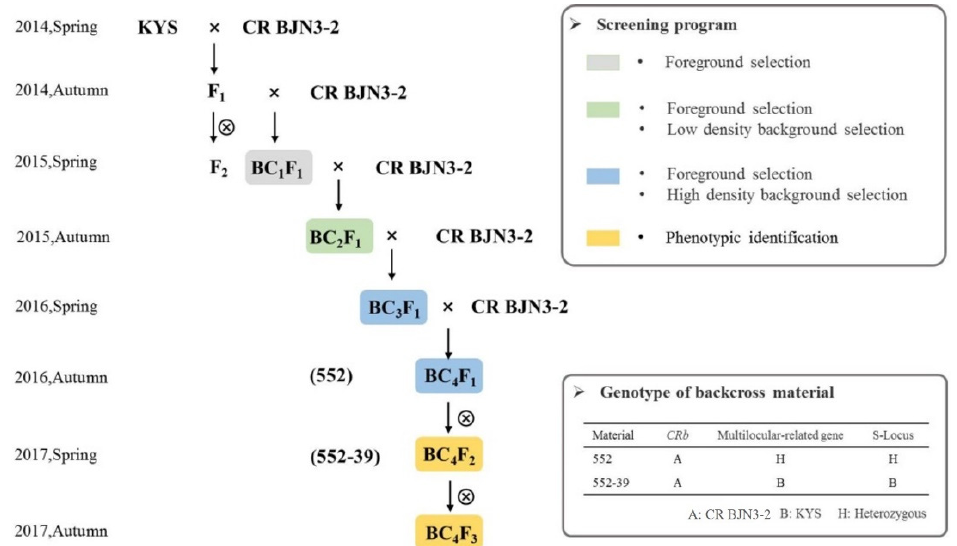
Figure 1. Schematic illustration of marker-assisted gene pyramiding in this study. CR BJN3-2: re-